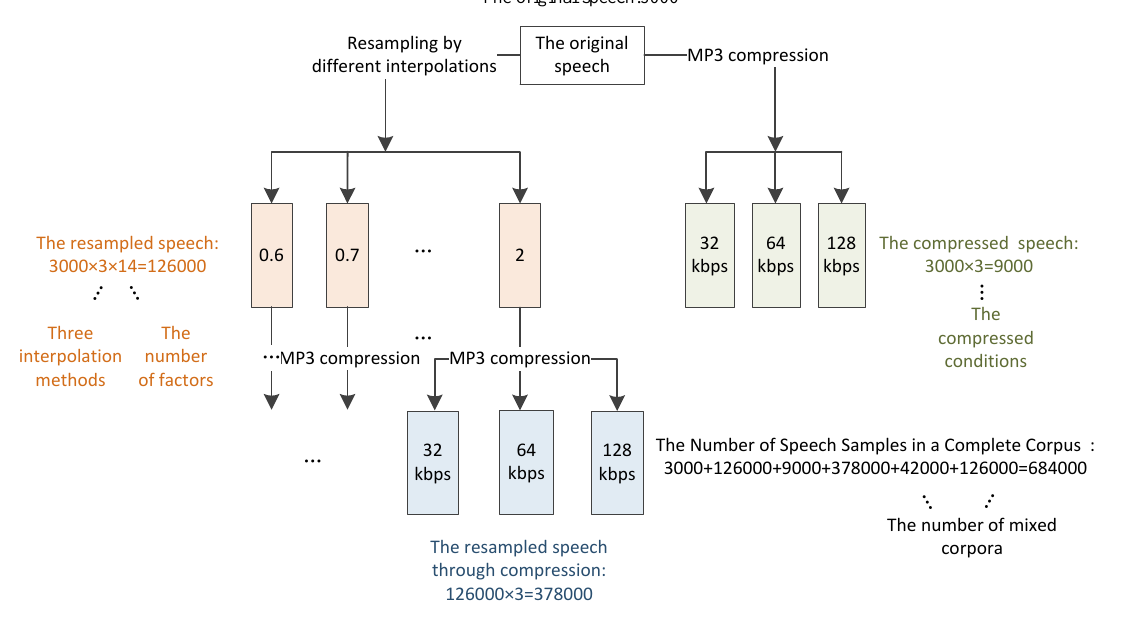
Figure 7. Production process of the